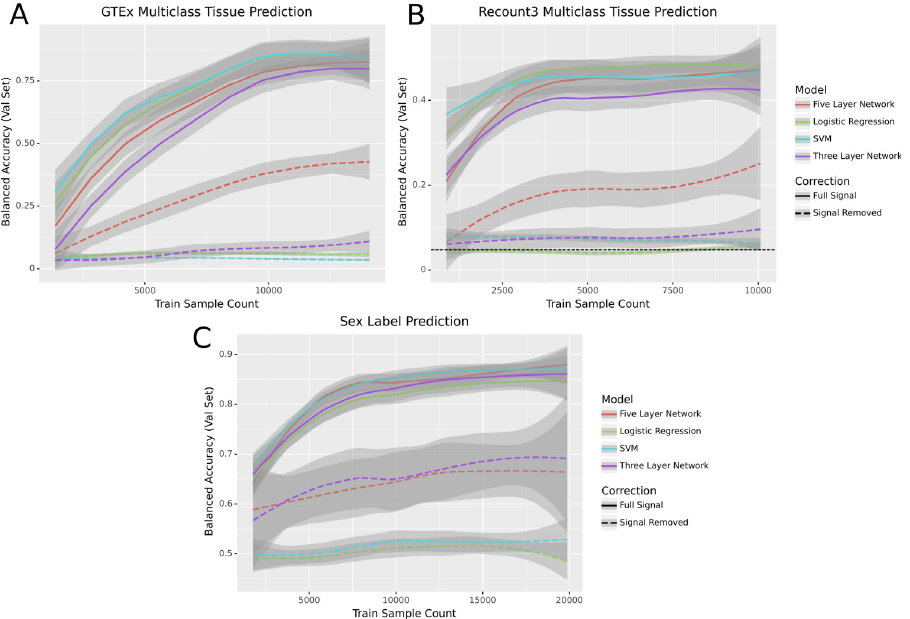
Fig 3. Performance of models across three classification tasks before and after signal removal. In each panel the loess curve and its 95% confidence interval are plotted based on points from three seeds, ten data subsets, and five folds of study-wise cross-validation (for a total of 150 points per model per panel). It is worth noting that “Sample Count” in these figures refers to the total number of RNA-seq samples, some of which share donors. As a result, the effective sample size may be lower than the sample